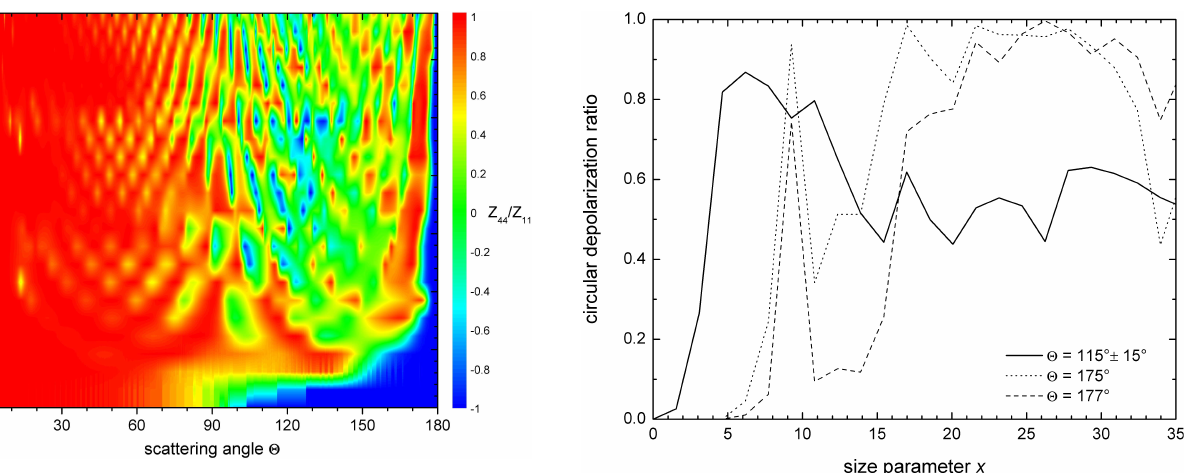
Fig. 5. Depolarization ratio δ C of spheres as a function of the size parameter x at 2 = 175 ◦ , 177 ◦ , and 115 ± 15 ◦